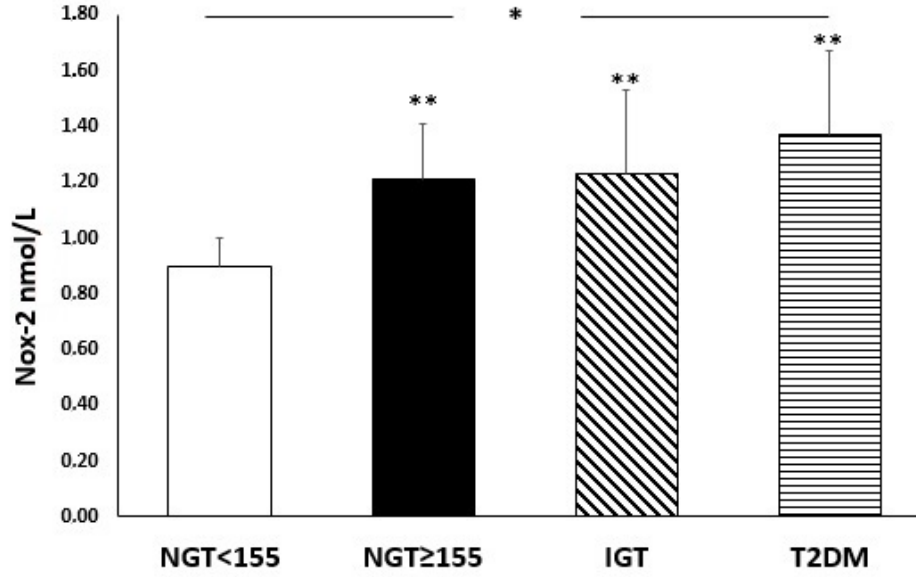
Figure 2. Serum levels of Nox-2 (nmol/L) in the four groups according to glucose tolerance status. * p < 0.0001 (ANOVA test); ** p < 0.0001 vs. NGT < 155 (Bonferroni post hoc test). There was a significant increase, from the first to the fourth group, in 8-isoprostane ( p < 0.0001) and Nox-2 ( p < 0.0001) serum levels, indicating a worsening in oxidative stress with the deterioration of metabolic status. In particular, 8-isoprostane ( p < 0.0001) and Nox-2 ( p < 0.0001) levels were significantly higher in the NGT ≥ 155 subjects compared to NGT < 155 group, without significant differences with IGT and diabetic patients.